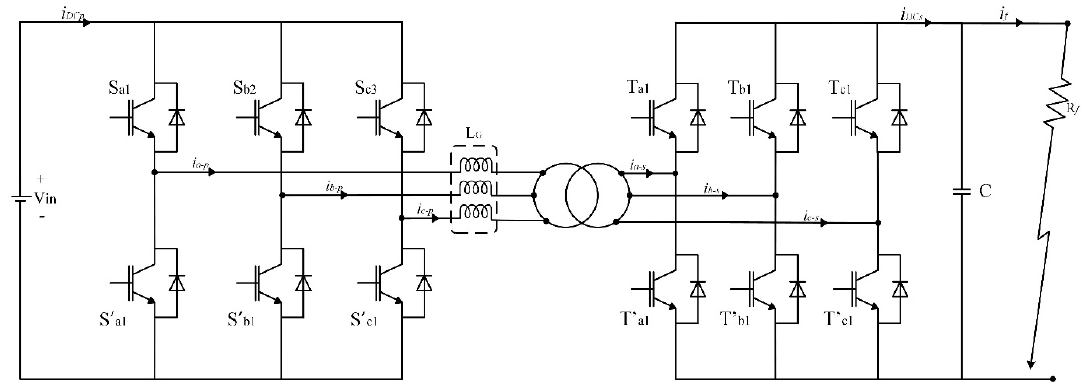
Figure 8. Basic circuit of DAB DC/DC converter and DC fault.